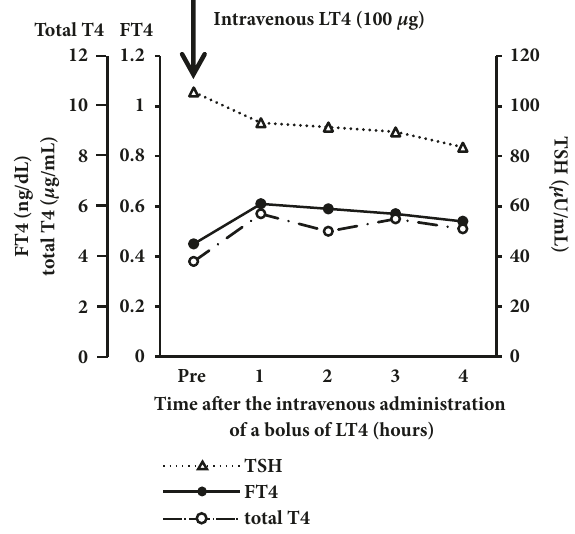
Figure 1: Serum thyroid hormone and TSH levels after the intra- venous administration of a single bolus of LT4 (100 𝜇 g) . Serum FT4 and total T4 levels both increased, peaked 1 hour after the administration, and gradually decreased